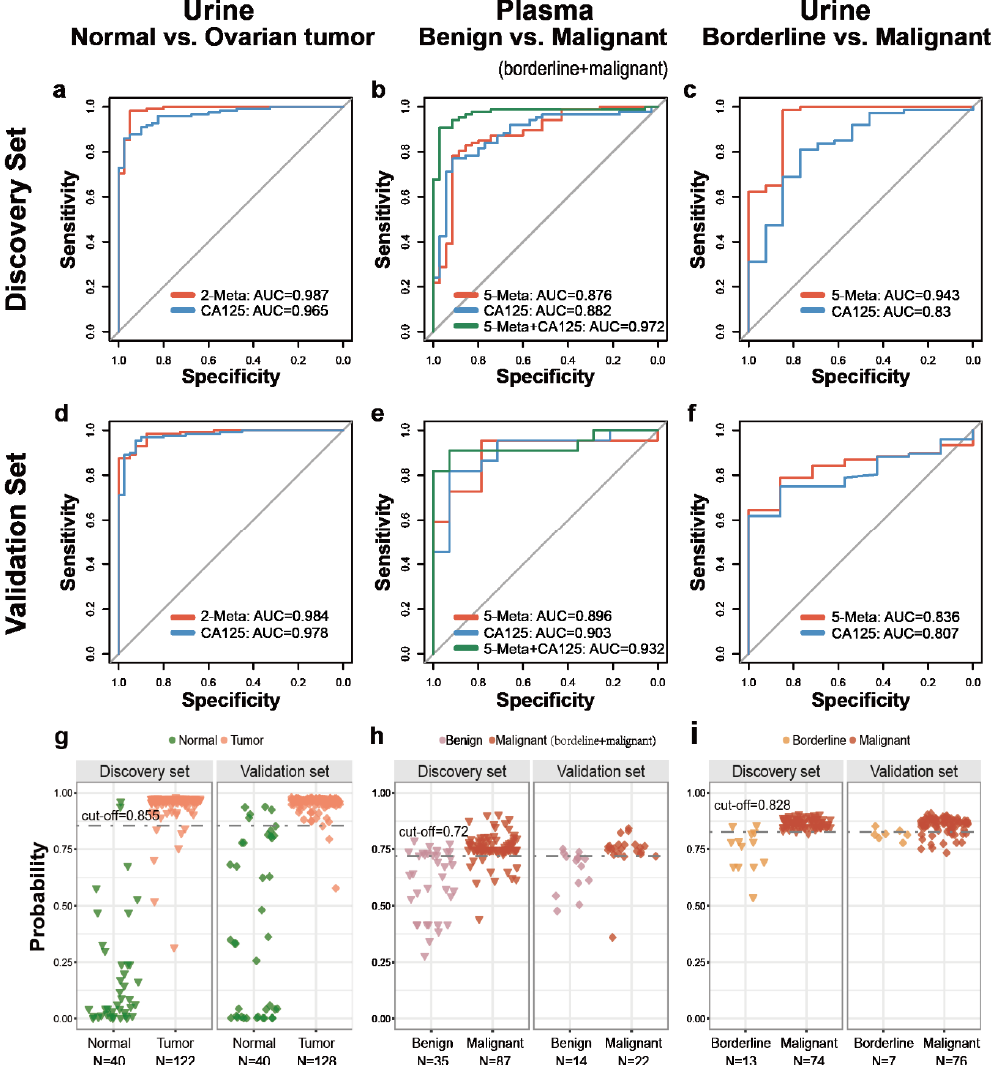
Figure 4. Diagnostic performance and prediction plot of biomarkers in urine or plasma sample. The diagnostic performance in the discovery set and validation set were shown via the receiver-operating characteristic (ROC) curves for comparison between ( a , d ) normal control versus ovarian tumors, ( b , e ) benign versus malignant (borderline + malignant), ( c , f ) borderline versus malignant ovarian tumors. The prediction accuracies by the biomarkers in the discovery set and validation set were compared between ( g ) normal control versus ovarian tumor, ( h ) benign versus malignant (borderline + malignant), ( i ) borderline versus malignant ovarian tumor. AUC = area under the curve. Red line indicates biomarker panel. blue line indicates CA125. Green line indicates the hybrid model based on biomarker panel and CA125.